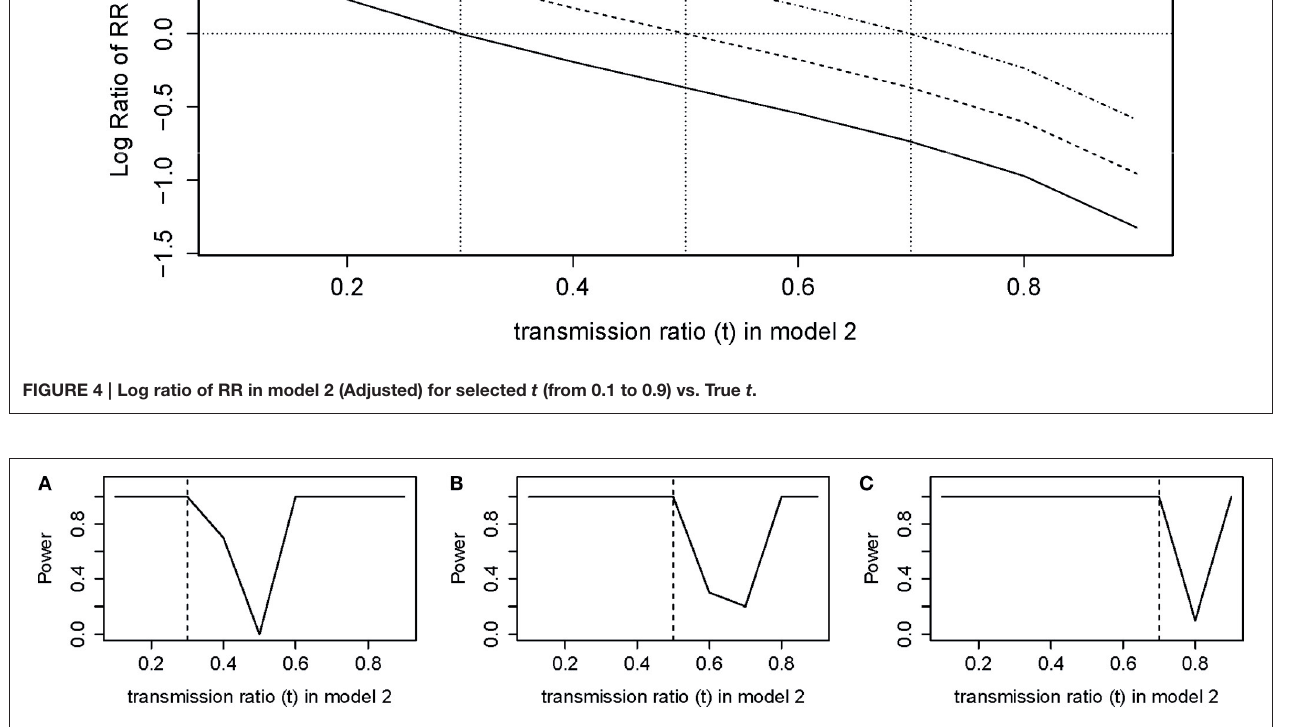
FIGURE 5 | Power of model 2 (Adjusted) for selected t (from 0.1 to 0.9) vs. true t (A) true t = 0.3 (B) true t = 0.5 (C) true t = 0.7.